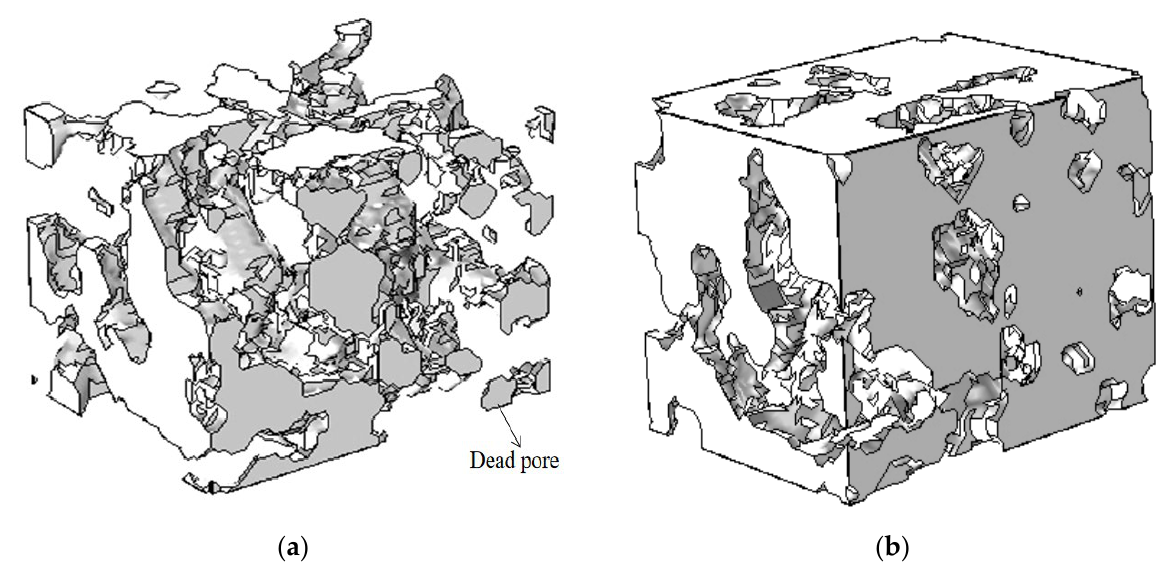
Figure 1. CL microstructure reconstruction. ( a ) Pore phase; ( b ) solid phase.